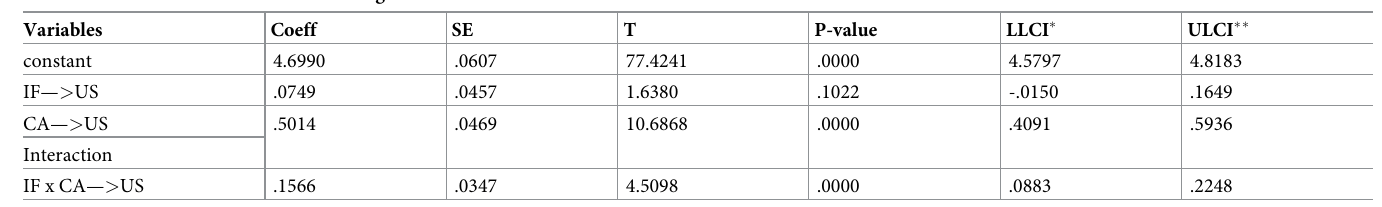
Table 8. Summarized results of moderating